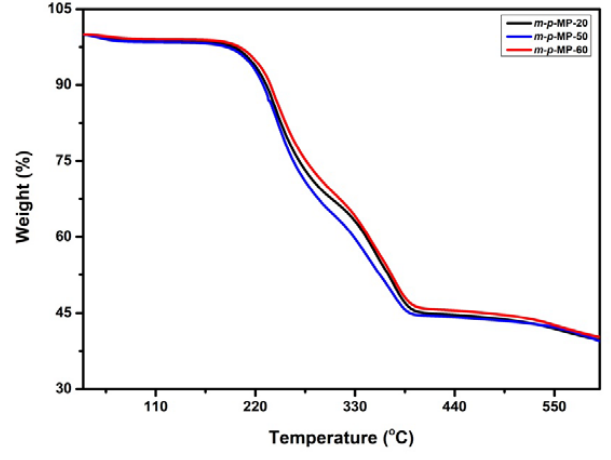
Figure 6. Thermo Gravimetric Analysis (TGA) graphs of the m-p -MP-20, m-p -MP-50, and m-p -MP-60.